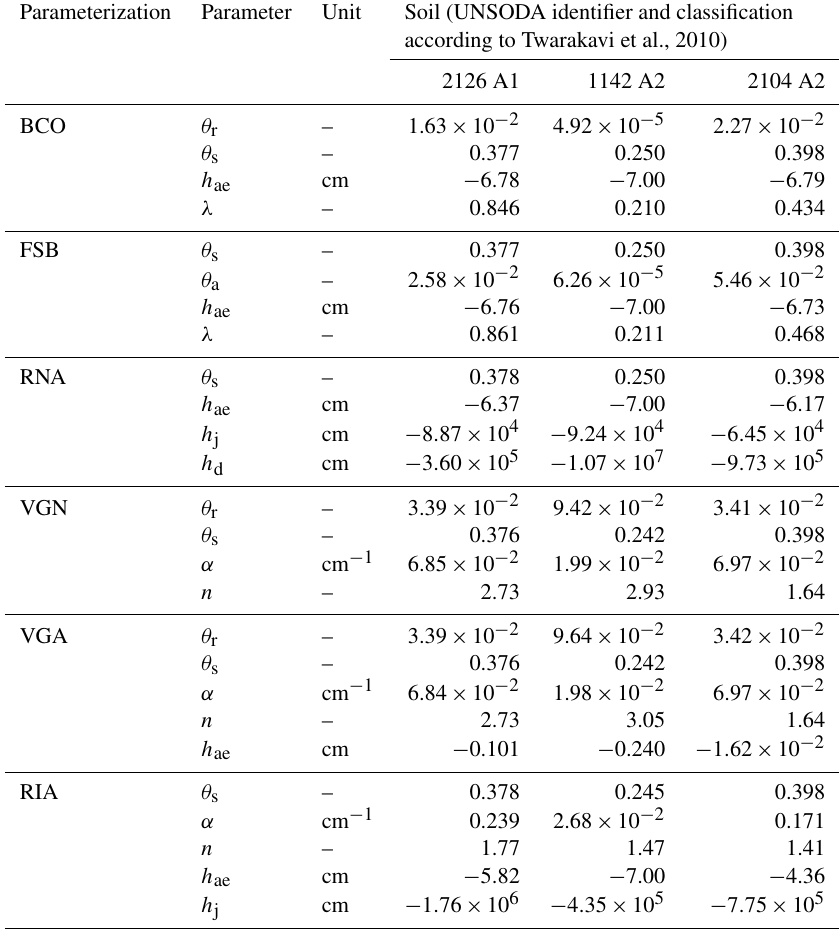
Table C1. The fitting parameters and their values for six parameterizations for sandy soils in the A1 and A2 classifications of Twarakavi et al. (2010) from the UNSODA database (National Agricultural Library, 2015; Nemes et al., 2001). The three-character parameterization label is explained in the main